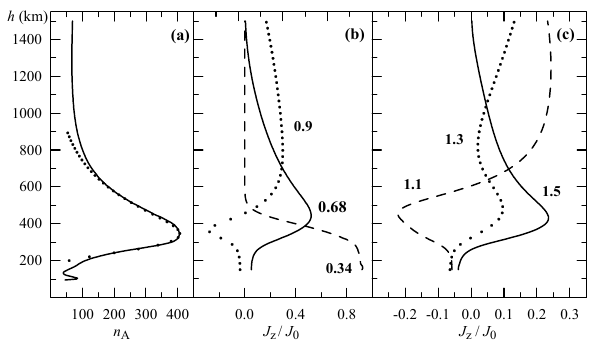
Fig. 1. Dependence on height h of: (a) the Alfv´en wave refractive